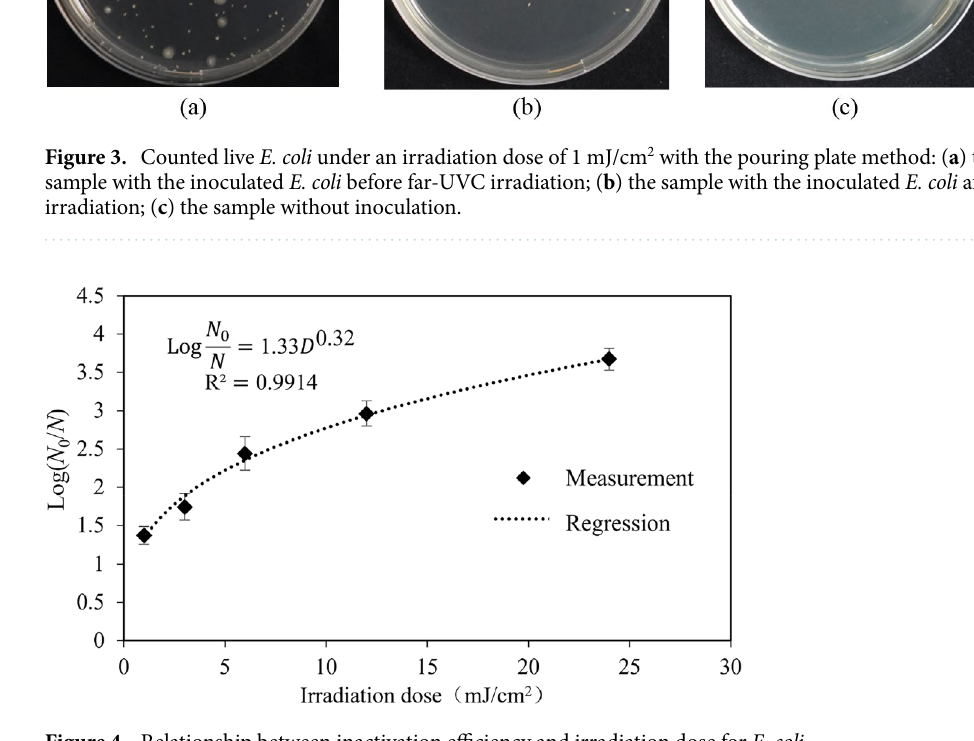
Figure 4. Relationship between inactivation efficiency and irradiation dose for E. coli